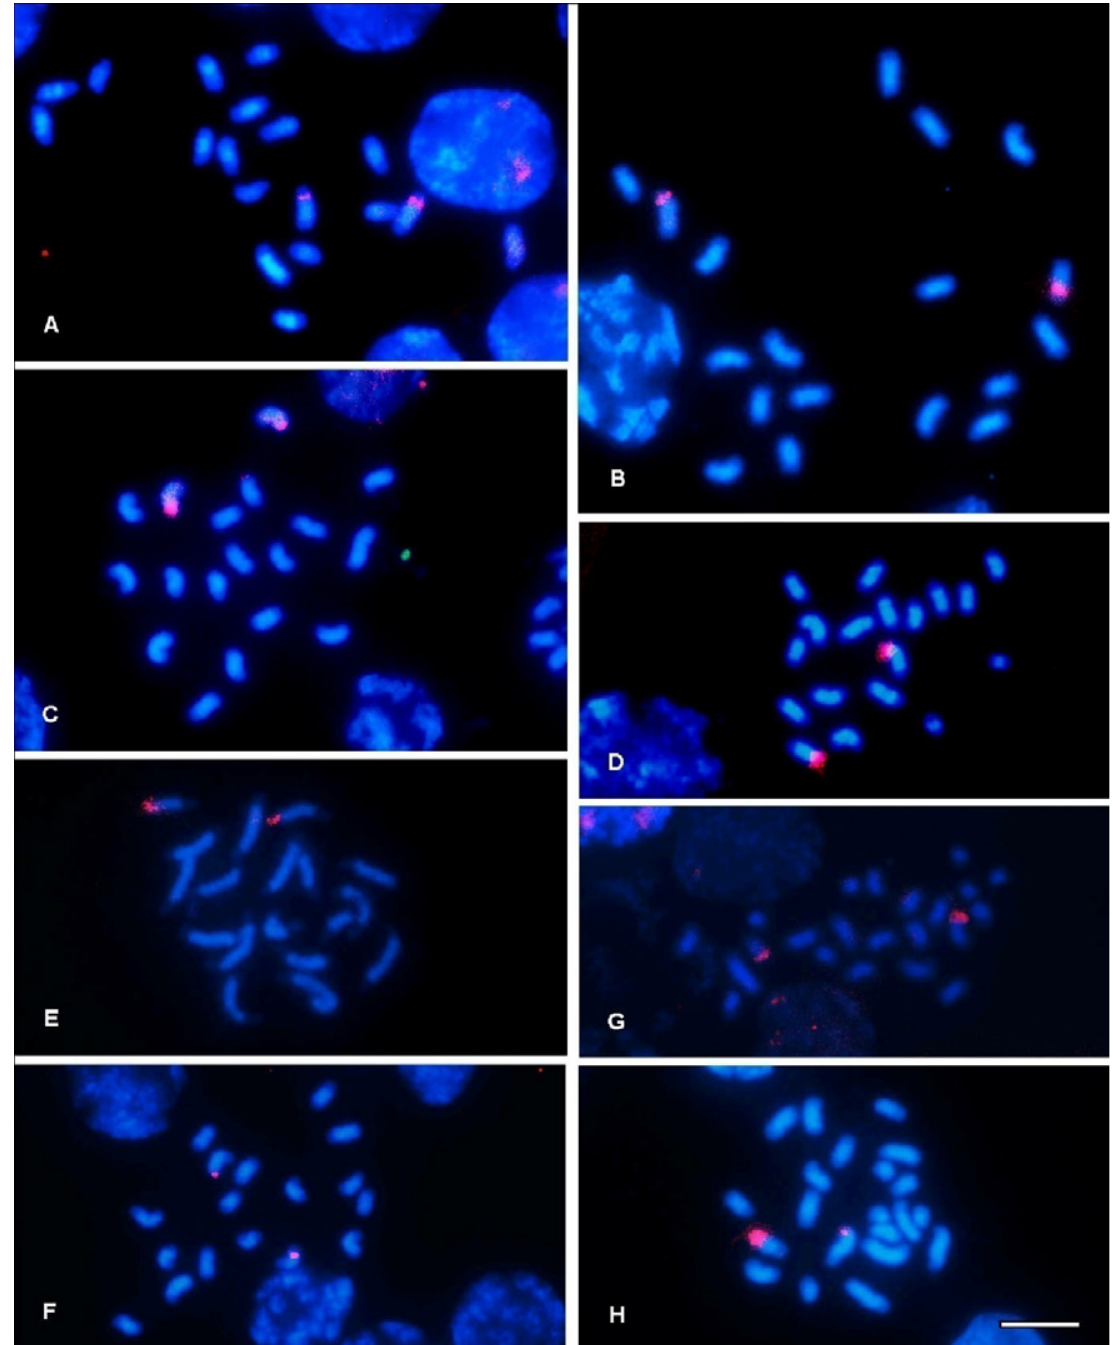
Fig 4 . FISH with 45S rDNA in metaphases of: Melipona fasciculata (A), Melipona grandis (B), Melipona flavolineata (C), Melipona scutellaris (D), Melipona fuscopilosa (E), Melipona mondury (F), M. seminigra pernigra (G) and M. seminigra abunensis (H). Bar = 10